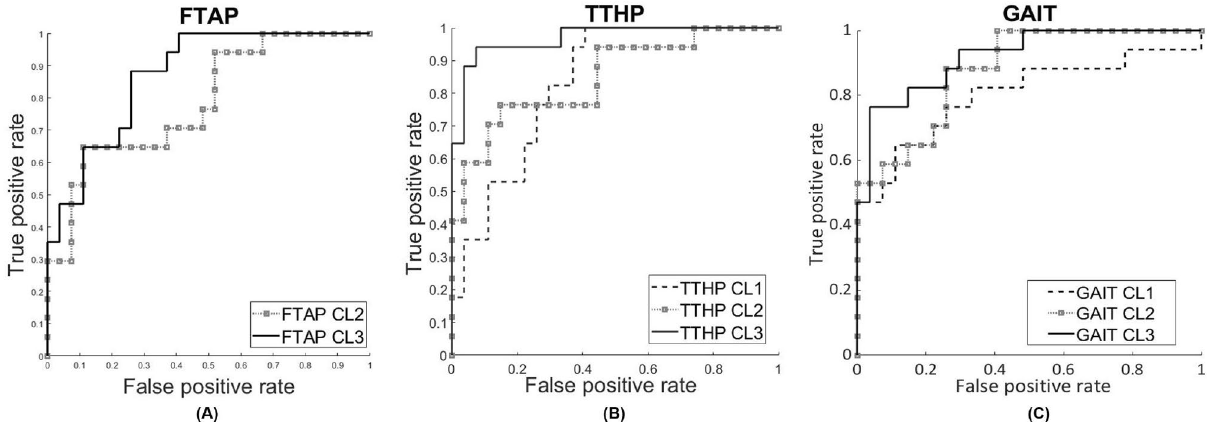
Figure 2. ROC curves regarding FTAP, TTHP and GAIT at CL1, CL2, and